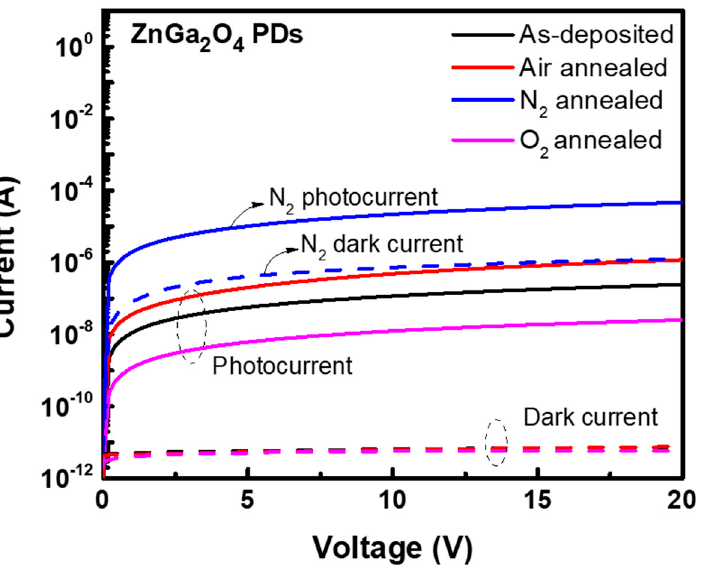
Figure 6. I–V characteristics of the as-deposited and annealed ZnGa 2 O 4 PDs under different anneal- ing ambiences.